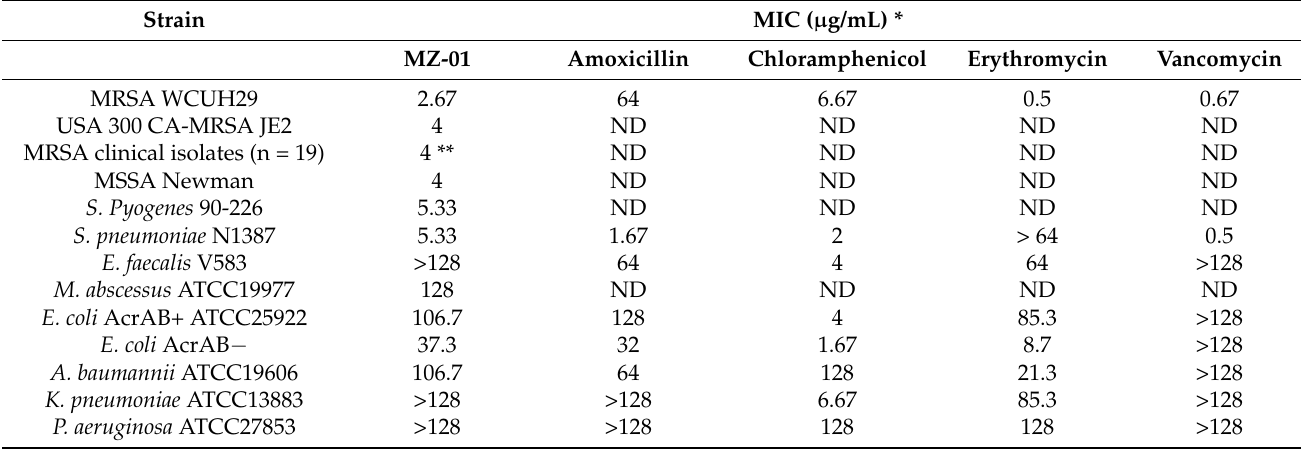
Table 1. Antibacterial profile of